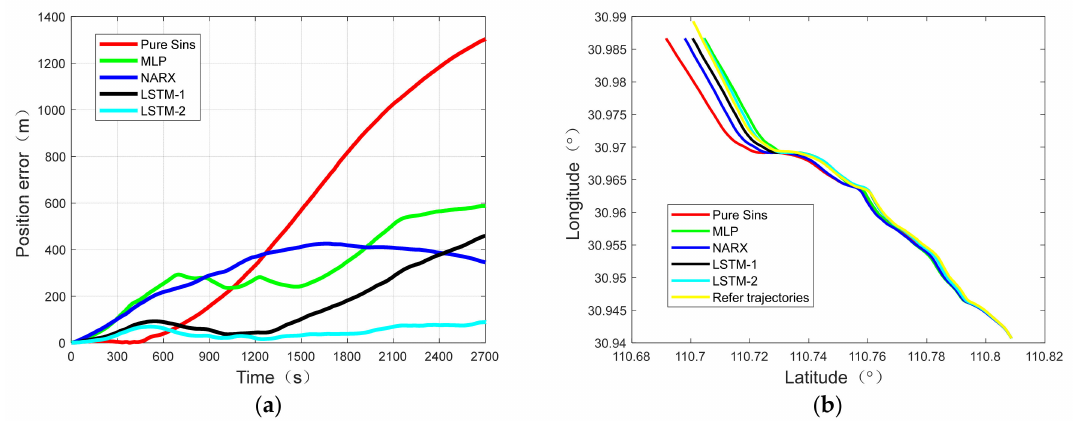
Figure 15. Comparison of navigation position error results: ( a ) Comparison of position errors; ( b ) Trajectory diagram in the case of DVL